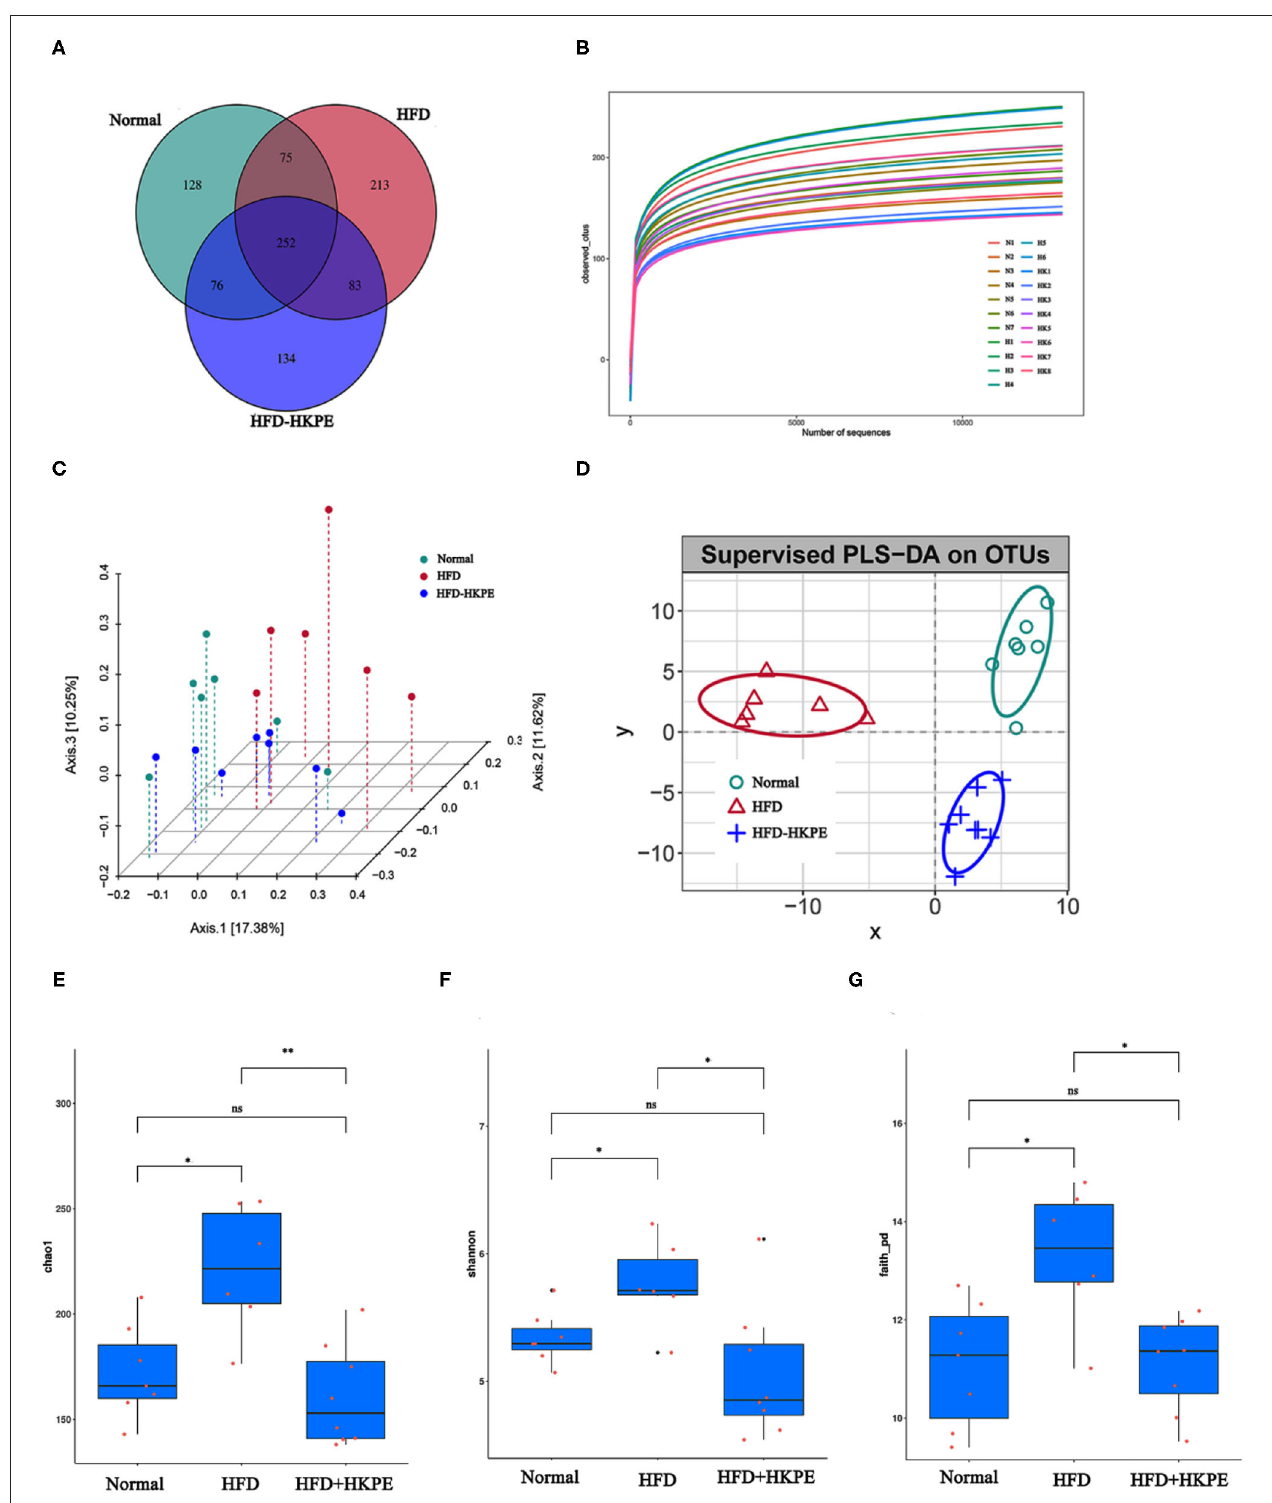
FIGURE 2 | KPE supplementation alters the alpha diversity analysis and beta diversity analysis. (A) Venn diagram showing the unique and shared OTUs in the different groups; (B) Dilution curve; (C) Principal Co-ordinate Analysis (pCoA) based on operational taxonomic units (out) results; (D) Partial Least Squares Discrimination Analysis (PLS-DA) based on operational taxonomic units (out) results; (E) Chao1 index; (F) Shannon index; (G) Faith-pd index. *, **, ns represent P < 0.05, P < 0.01, P > 0.05, respectively.